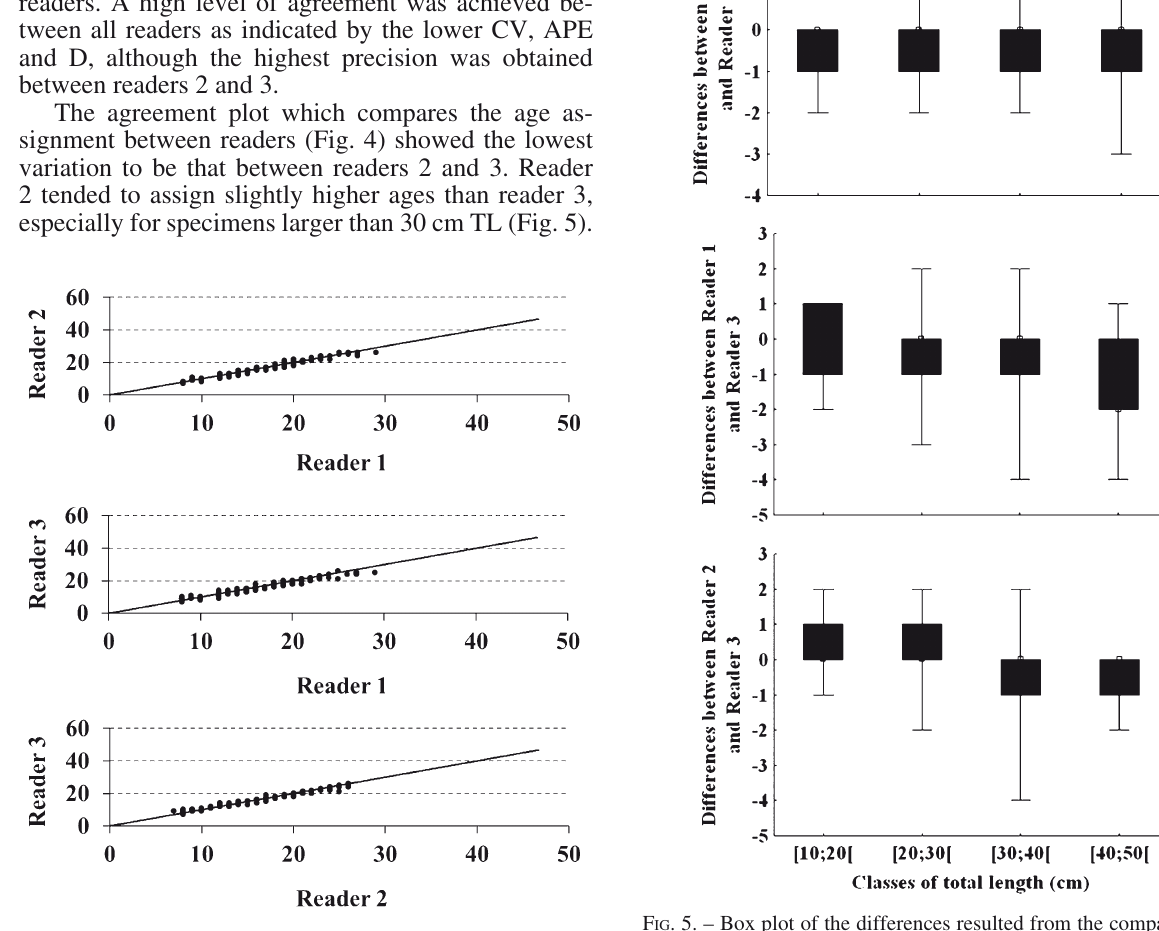
f iG . 4. – Agreement plot for comparisons between ages assigned by readers 1, 2 and 3 in whole otoliths of Pontinus kuhlii .